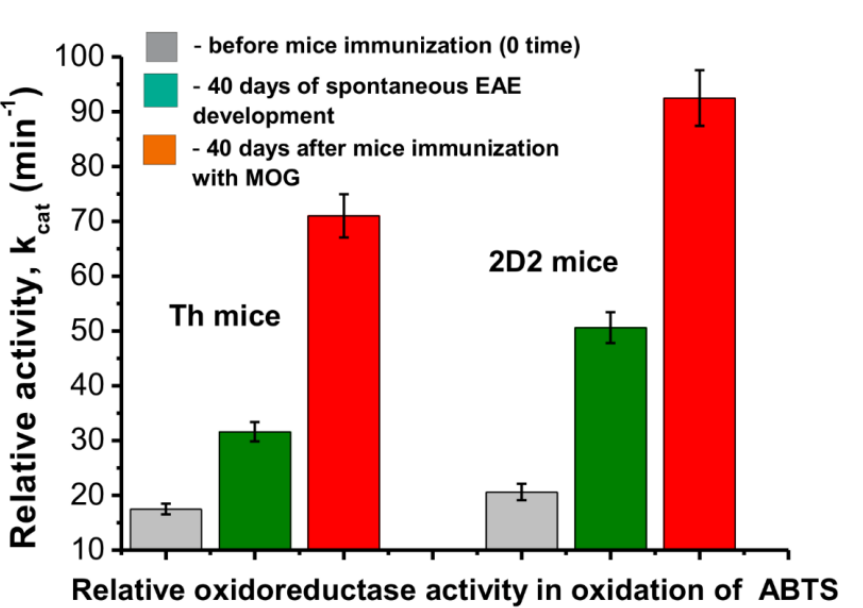
Figure 5. Relative values of k cat characterizing the rate of ABTS oxidation by IgGs from the blood of